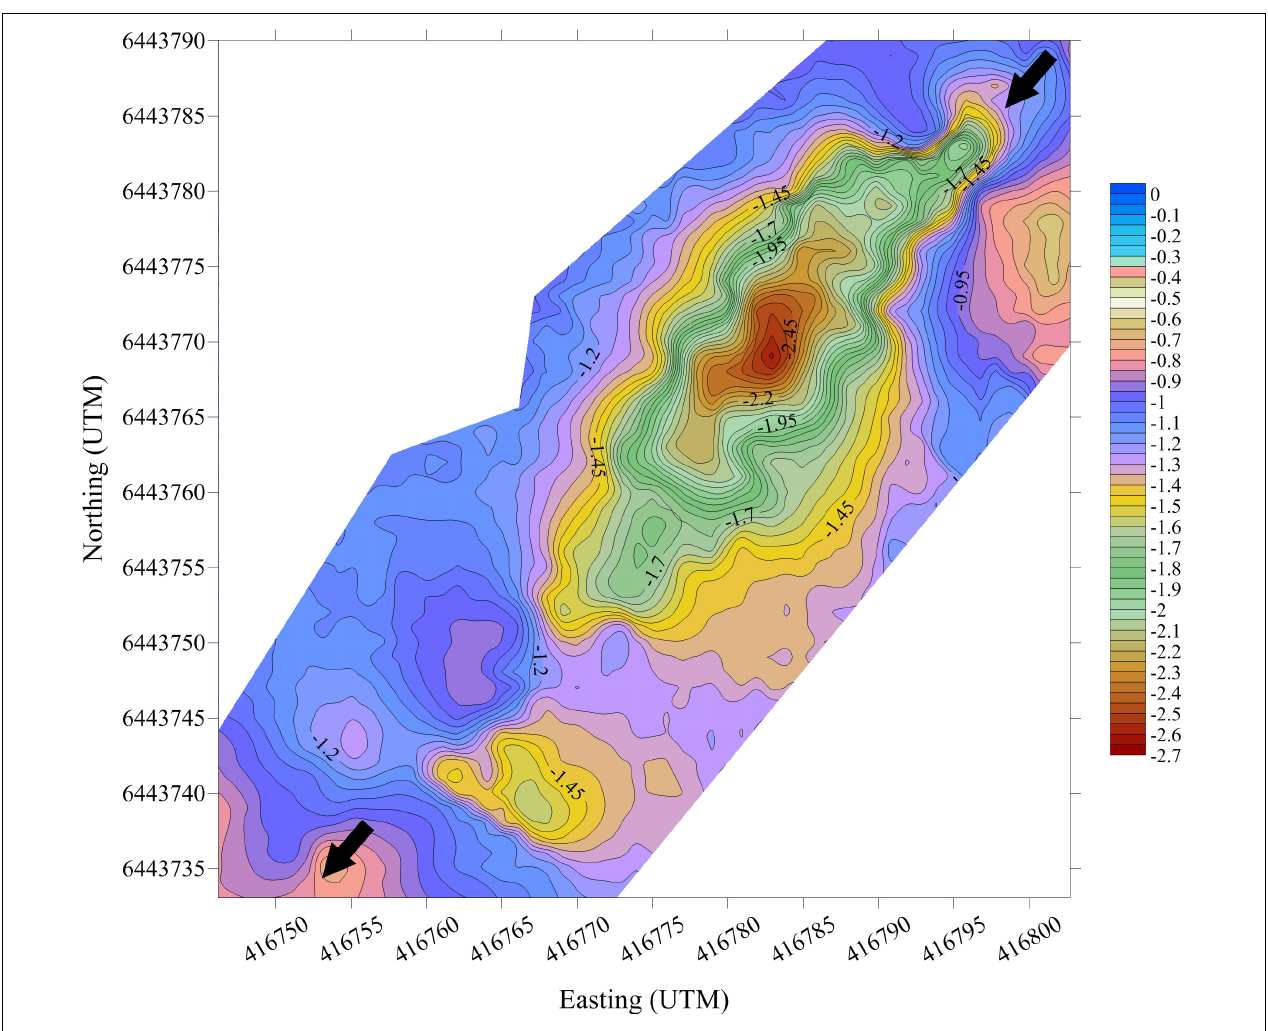
FIGURE 8 | Bathymetry of a pool along the Canning River. Color scale indicates water depth in meters and the arrows indicate the direction of